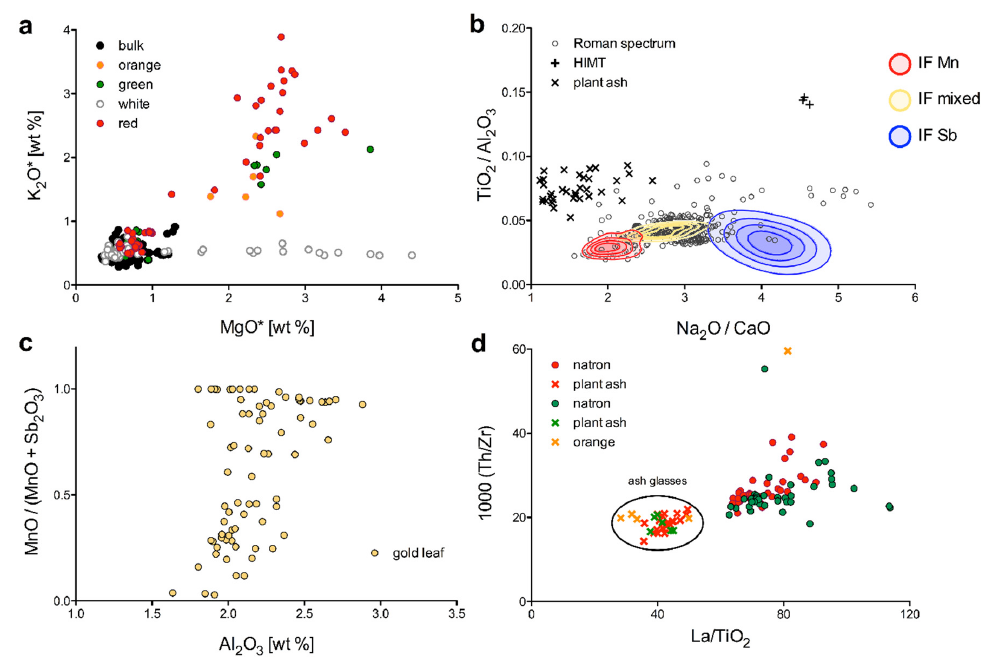
Figure 2. Base glass composition of the tesserae from Noheda. ( a ) Magnesium and potassium oxide concentrations discriminate the orange, and some of the green, red, and white tesserae from the bulk of the assemblage; ( b ) TiO 2 /Al 2 O 3 and Na 2 O/CaO ratios illustrate the overall compositional